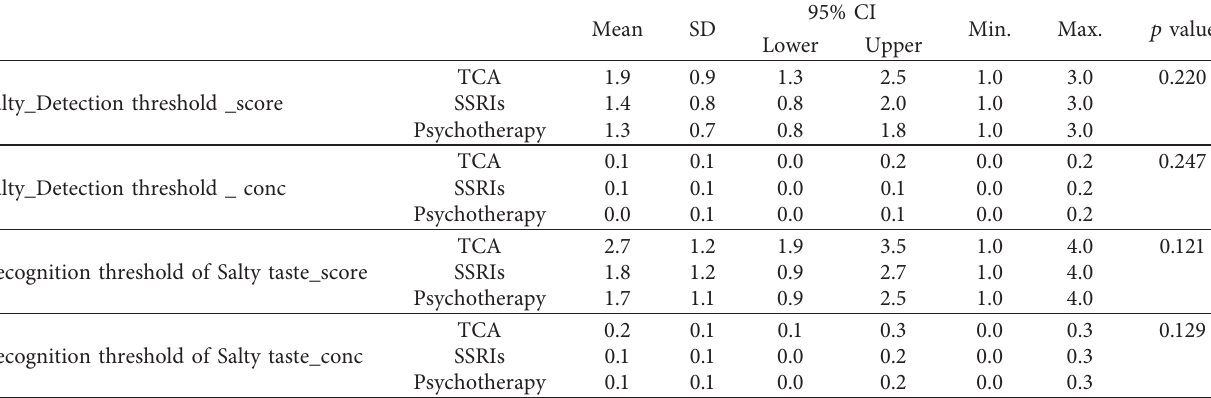
Table 3: Descriptive statistics and one-way ANOVA for salt detection and recognition thresholds scores and concentrations among the tested groups.